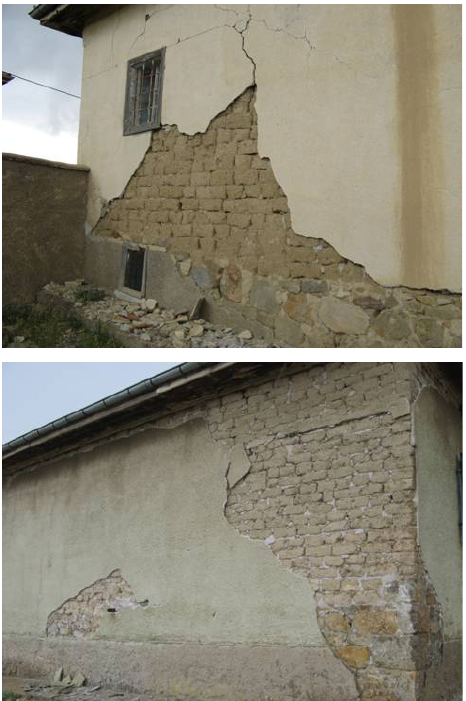
Fig. 16. Examples of out-of-plane failure (swelling) on the Fig. 16 Examples of out-of-plane failure (swelling) on the structural walls structural walls.